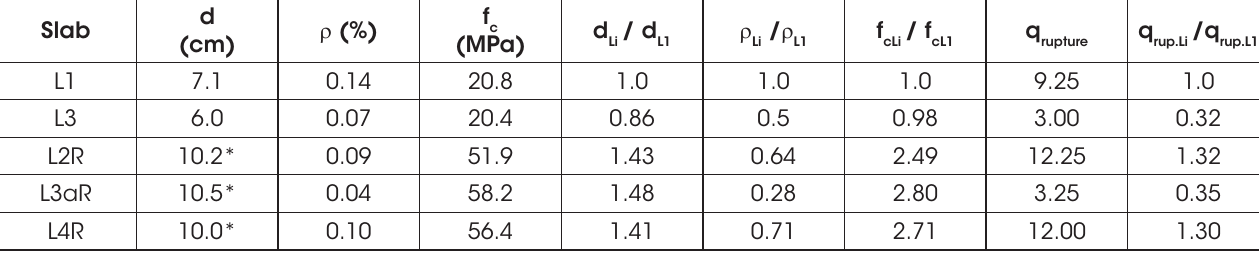
Details summary, slab characteristics and failure loads of all slabs